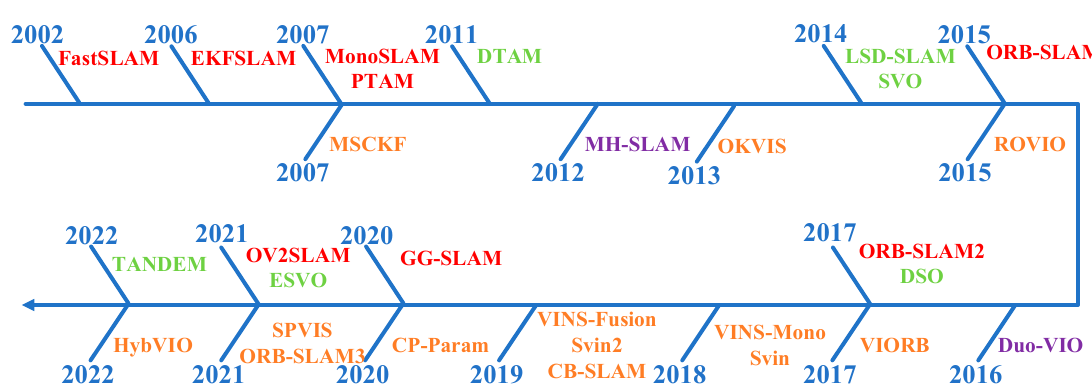
Figure 1. Pipeline of geometry-based methods.